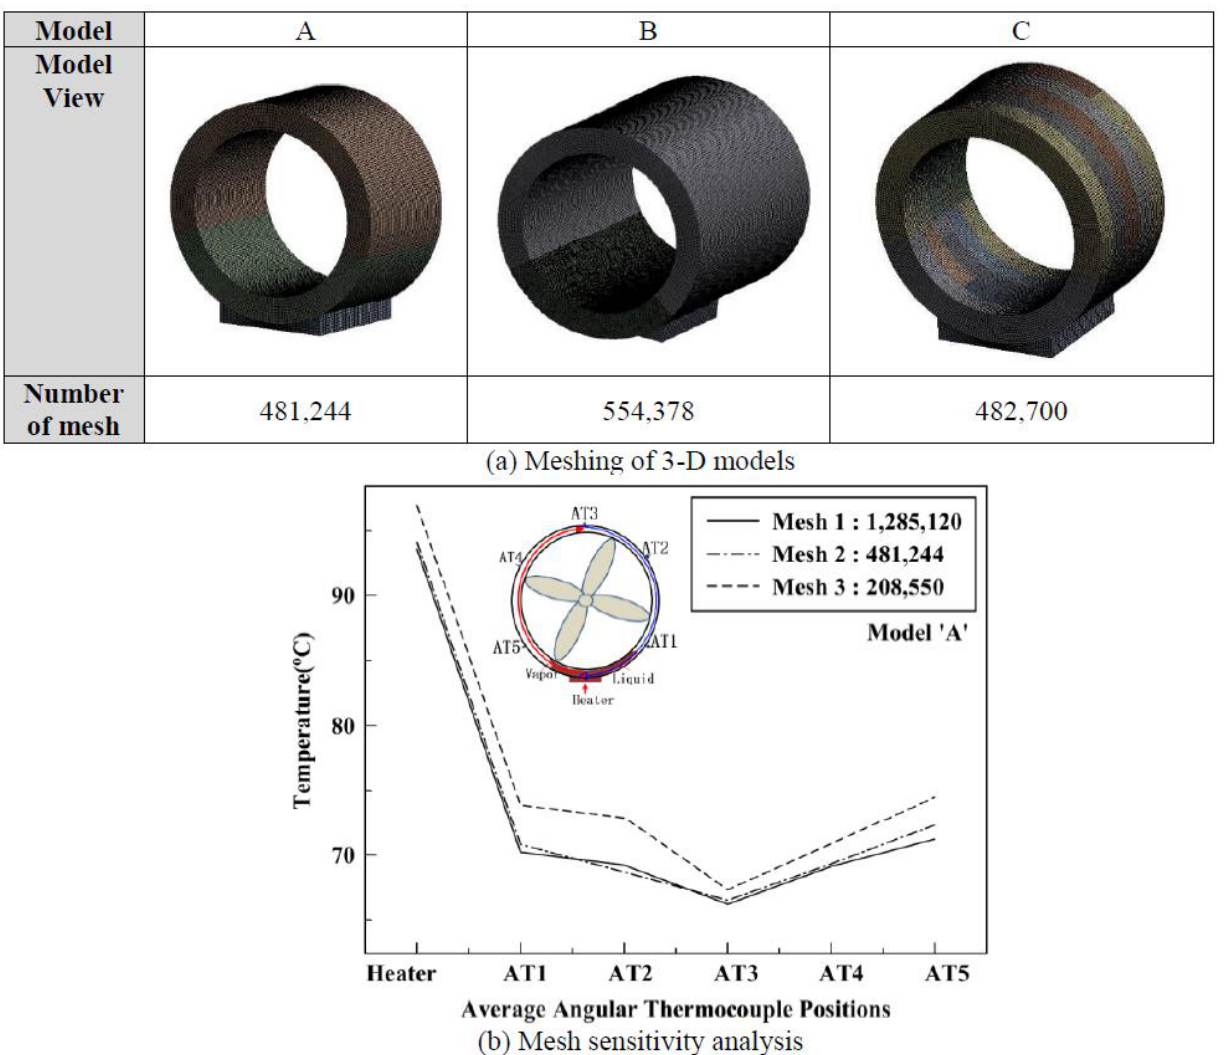
Figure 9. Mesh sensitivity analysis and meshing of 3D models.